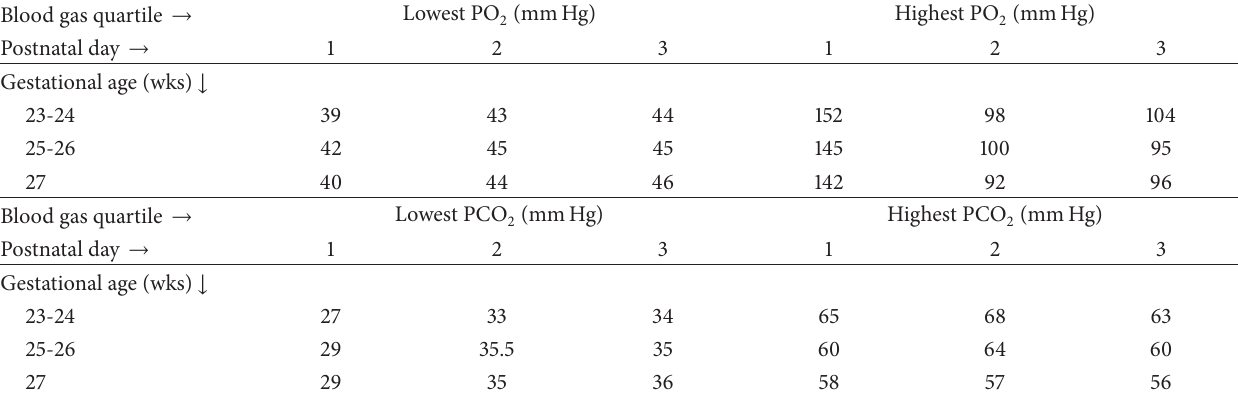
Table 1: The values that define the lowest and highest quartiles of each blood gas on each day in each gestational age group. Blood gas quartile → Lowest PO 2